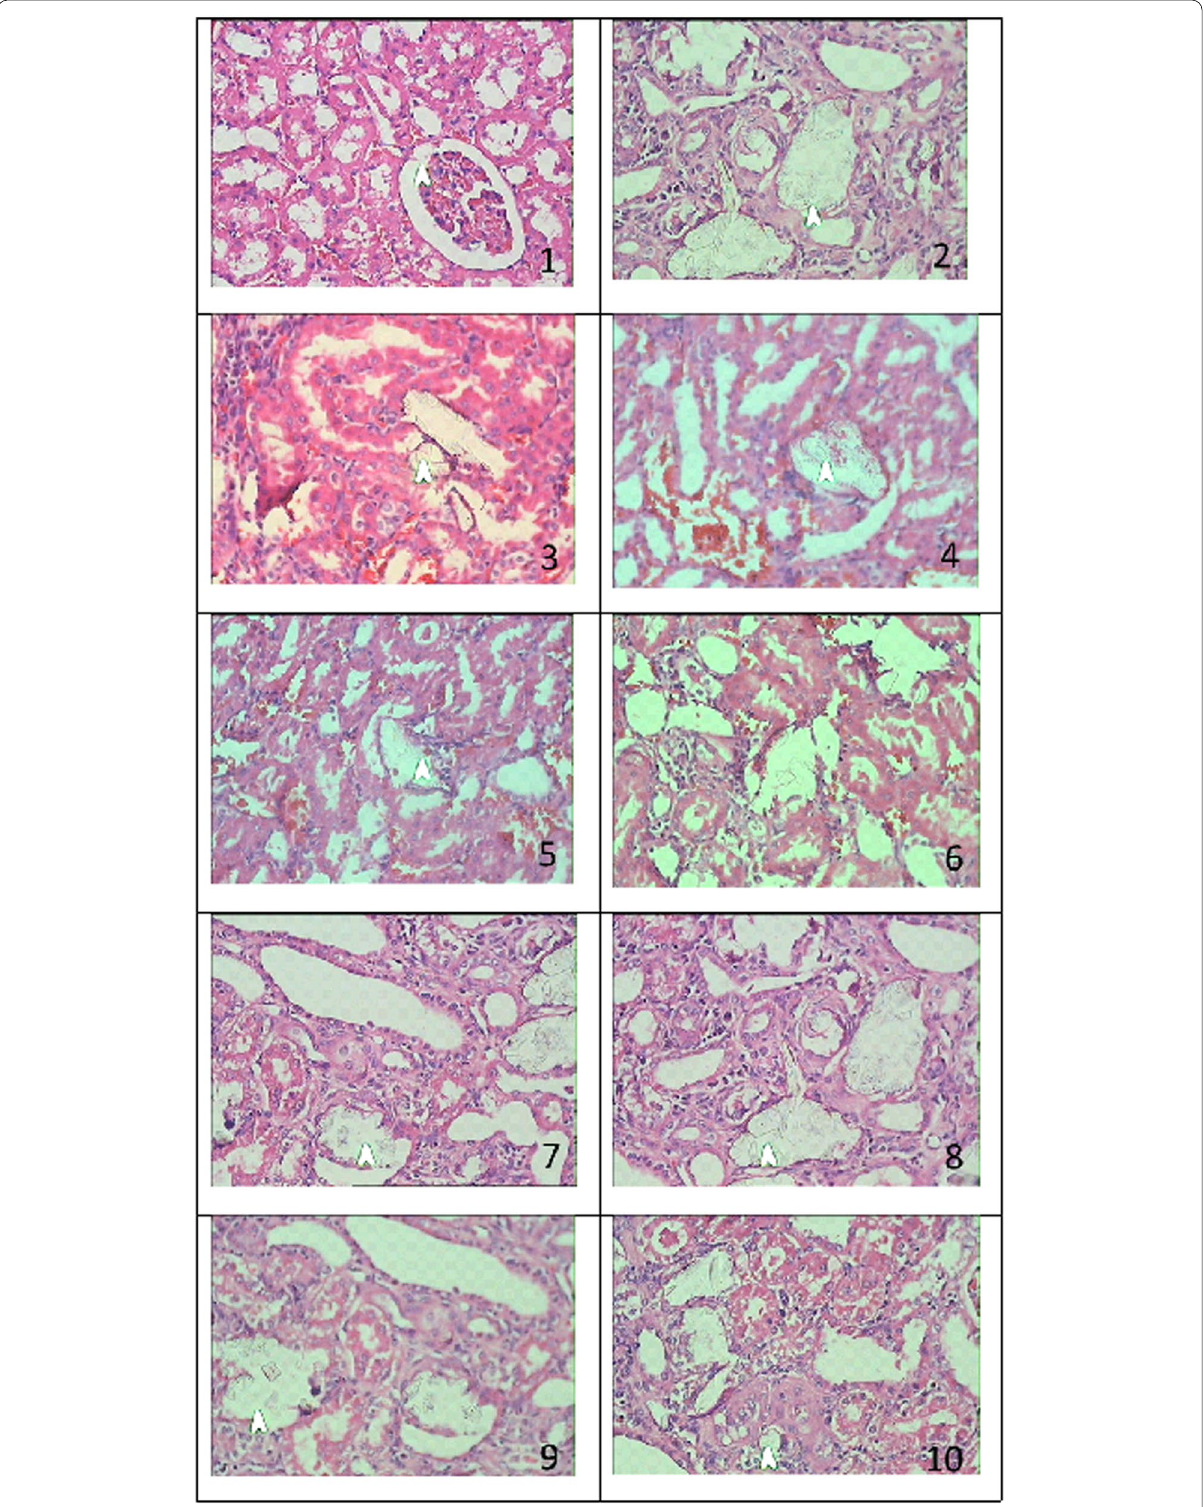
Fig. 3 Histopathology of kidneys of animals treated with selected source plants of Pashanabheda in comparison with control group. 1: Normal Control; 2: Disease control: 3&4: Treated with BC extracts; 5&6: Treated with AL extracts; 7&8: Treated with RA extracts; 9&10: Treated with PA